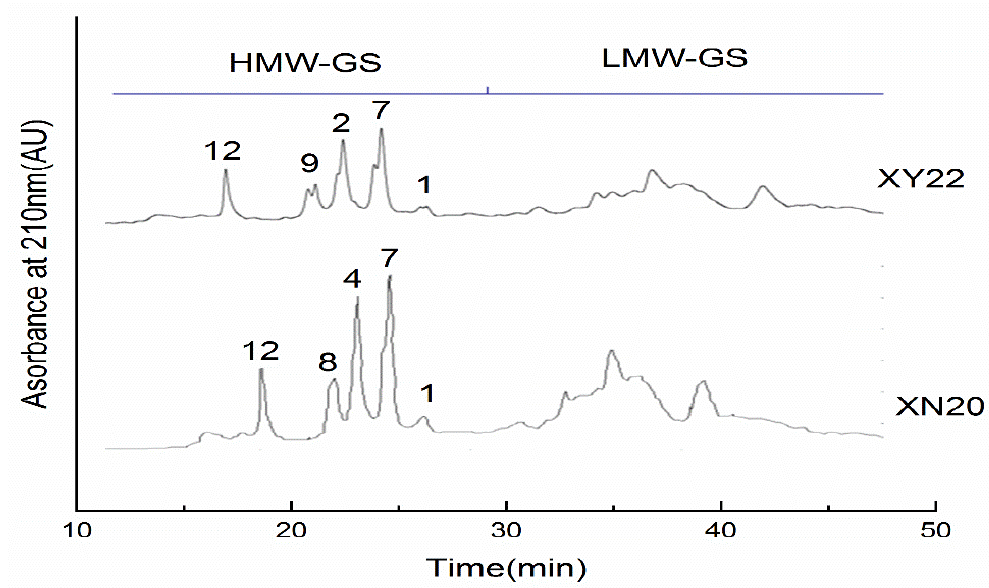
Figure 7. Reverse phase high performance liquid chromatography (RP-HPLC) image of high molecular weight gluten subunit (HMW-GS). KFA was the potassium foliar application on wheat. CK was applied as the same amount of water. Table 4. Variance analysis of the effects of year, experimental site, and foliar application stage